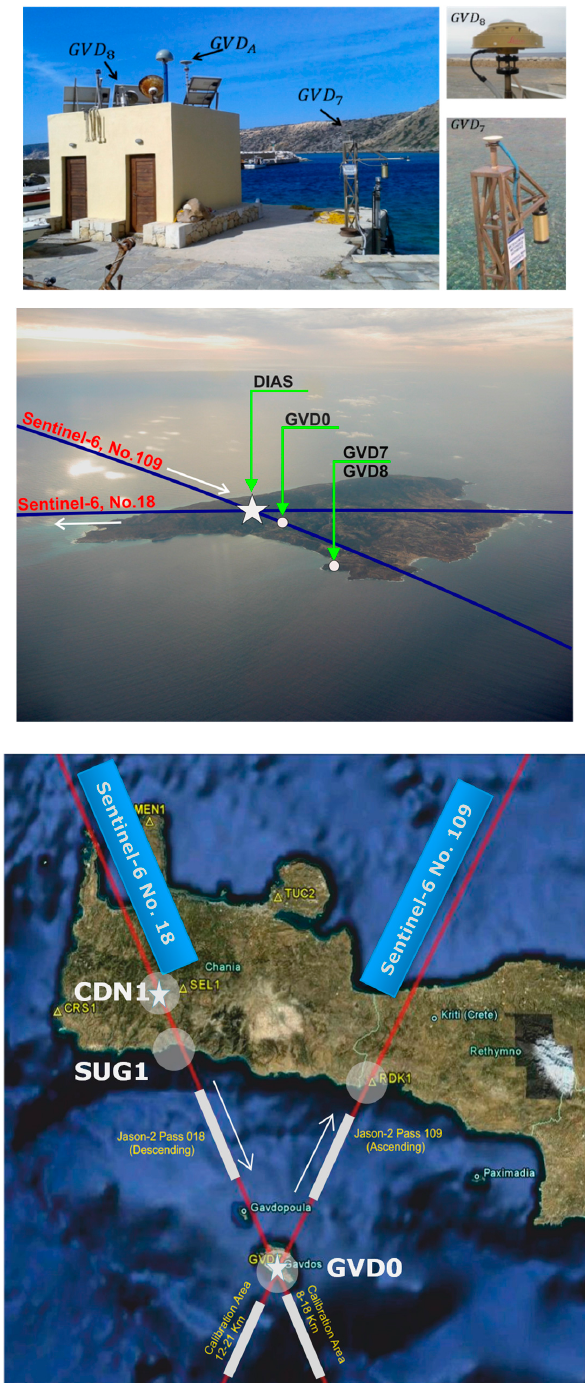
Figure 10. The sea-surface calibration facility in Gavdos island, south of Crete. An example with Sentinel-6/Jason-CS orbits.